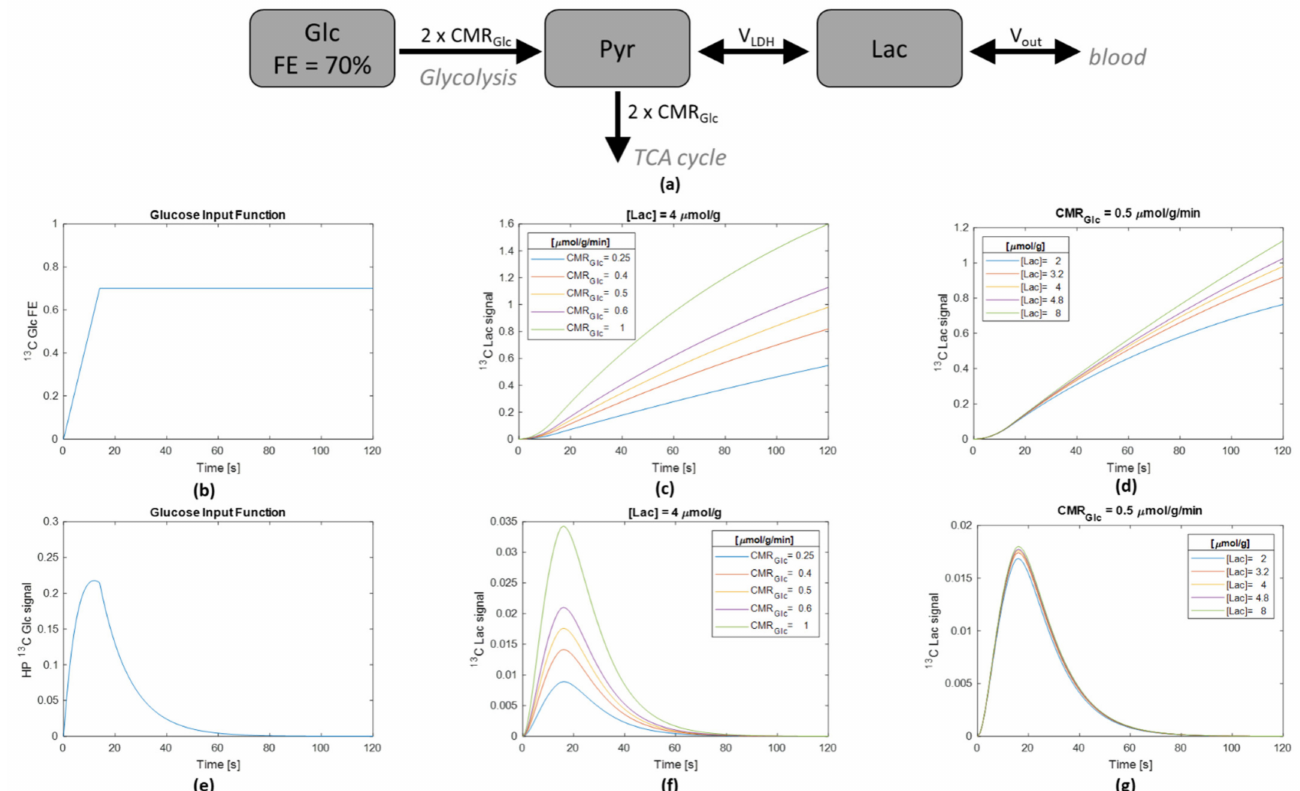
Figure 3. Analysis of the sensitivity of the measured HP 13 C Lac signal to specific metabolic parameters. Simulations were performed using a three-pool model representing the 13 C-labeling kinetics of Glc, Pyr, and Lac in the brain ( a ). The model is characterized by three metabolic fluxes: the cerebral metabolic rate of glucose (CMR Glc ), the conversion between pyruvate and lactate through lactate dehydrogenase (V LDH ) and the exchange between blood lactate and brain tissue lactate (V out ). ( b ) A typical step input function for glucose fractional enrichment reaching 70% after 14 s was used. ( c ) The sensitivity of the Lac 13 C concentration relative to the CMR Glc was assessed by varying the CMR Glc from 0.25 micromole/g/min to 1 µ mol/g/min, with a nominal Lac pool size of 4 µ mol/g. ( d ) The sensitivity of the Lac 13 C concentration relative to the Lac pool size was assessed by varying the Lac pool size from 2 µ mol/g to 8 µ mol/g, with a nominal CMR Glc of 4 µ mol/g. In ( e – g ), the physical parameters influencing the measured 13 C HP signal were included in the differential equations of the model (T 1 decay and repetitive RF pulsing). The 13 C Lac signal is shown for a varying CMR Glc with a fixed endogenous Lac concentration ( f ) or for varying endogenous Lac concentration with a fixed CMR Glc ( g